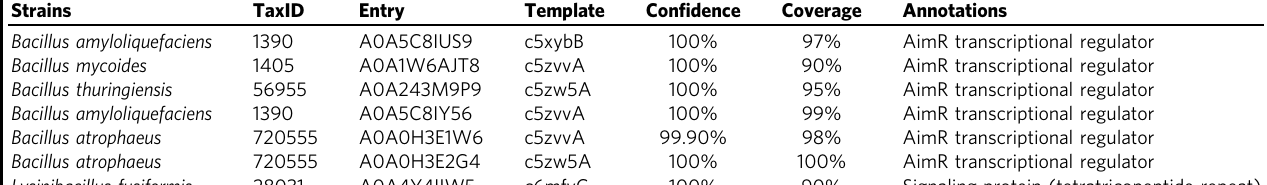
Table 2 Results of another eight expanded entries without existing annotations based on Phyre 2 . Strains